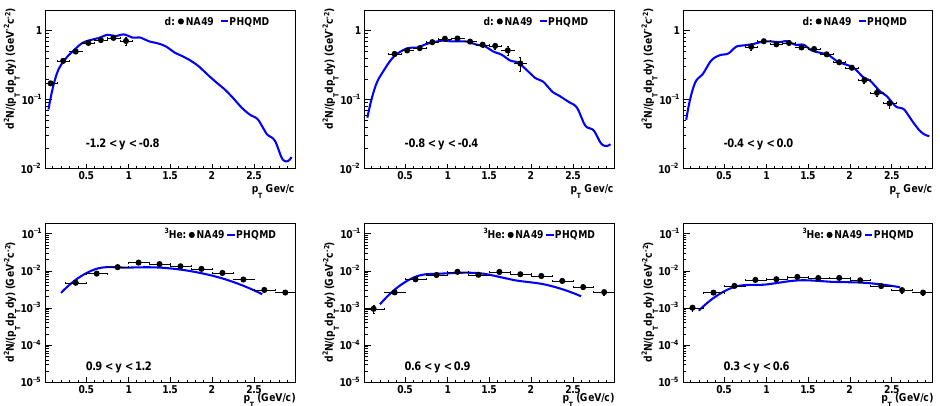
Figure 3. Transverse momentum spectra of deuterons and 3 He in selected rapidity bins for the central Pb+Pb collisions. Experimental data (black circles) are taken from NA49 Collaboration